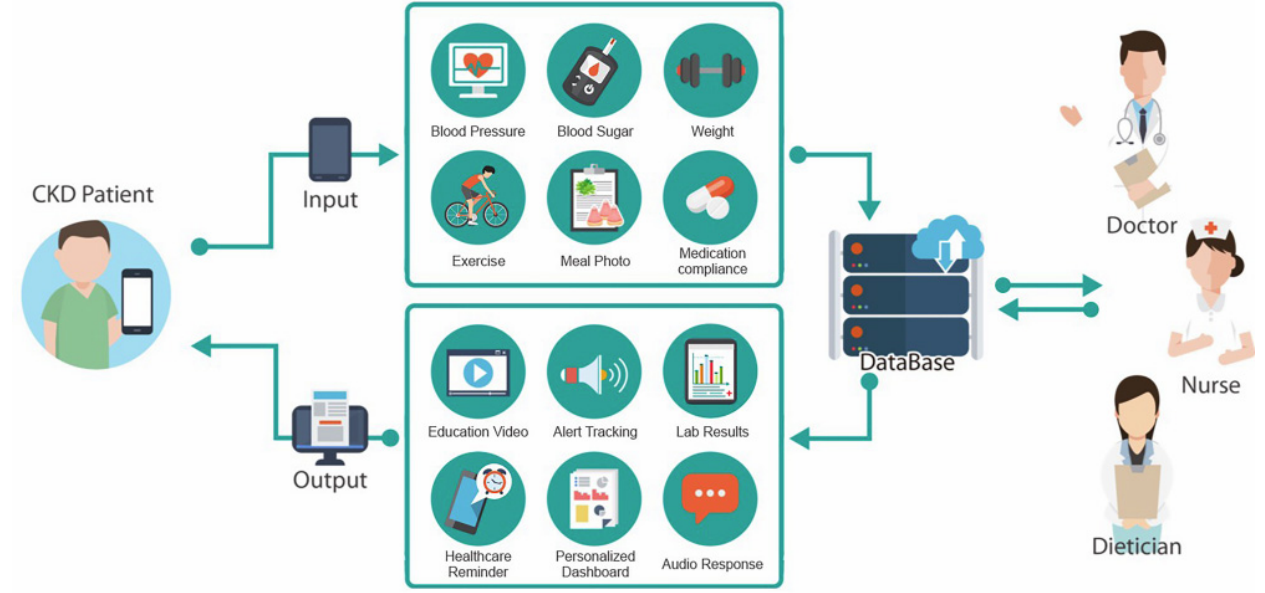
Figure 2. iCKD health management application platform.